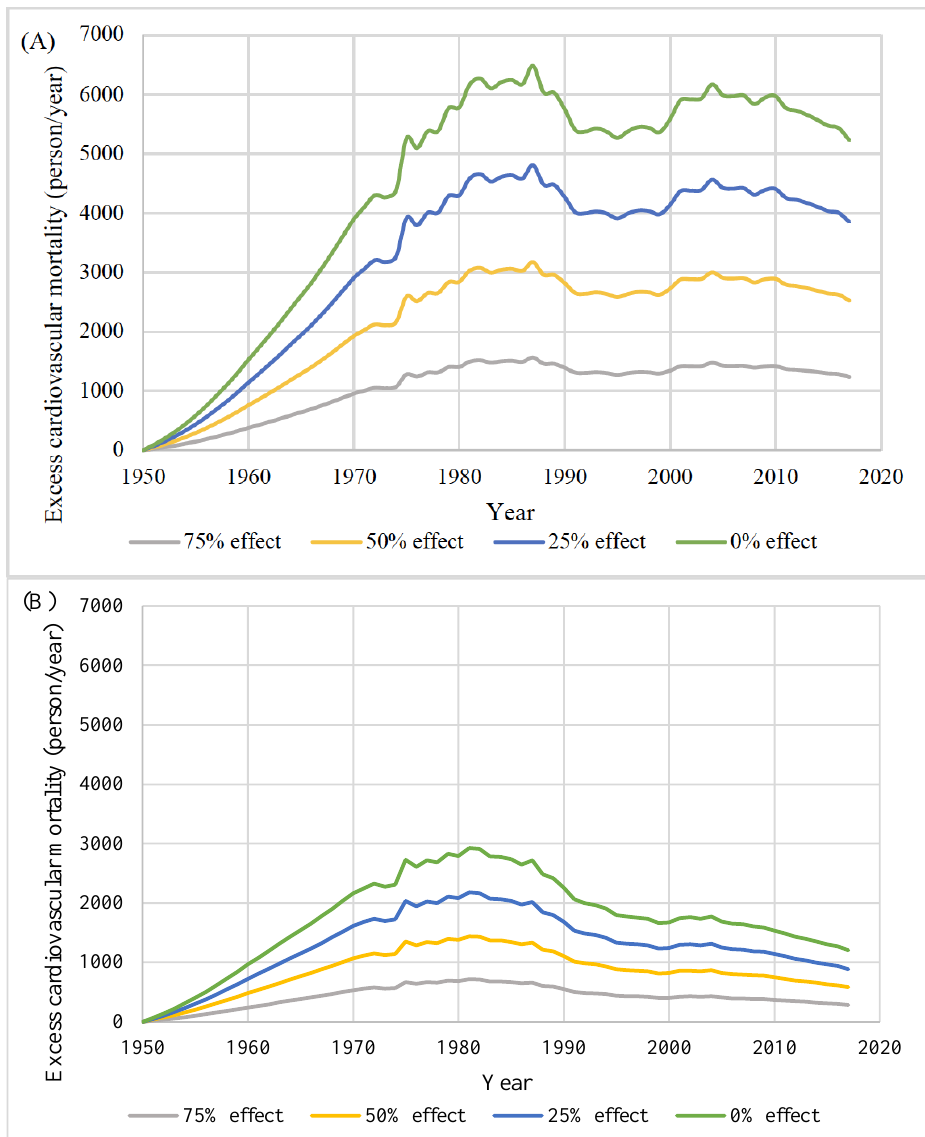
Figure 4. Absolute excess cardiovascular mortality by scenario in men ( A ) and women ( B ): 75% effect, 75% of the actual effect of salt-intake reduction; 50% effect, 50% of the actual effect of salt-intake reduction; 25% effect, 25% of the actual effect of salt-intake reduction; 0% effect, no effect of salt-intake reduction since 1950.